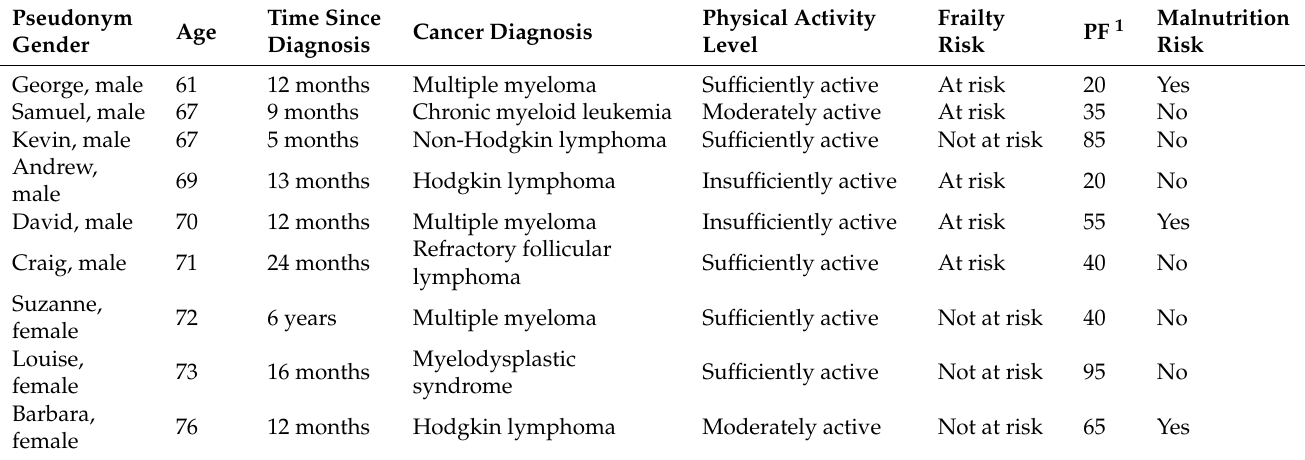
Table 2. Characteristics of participants from semi-structured